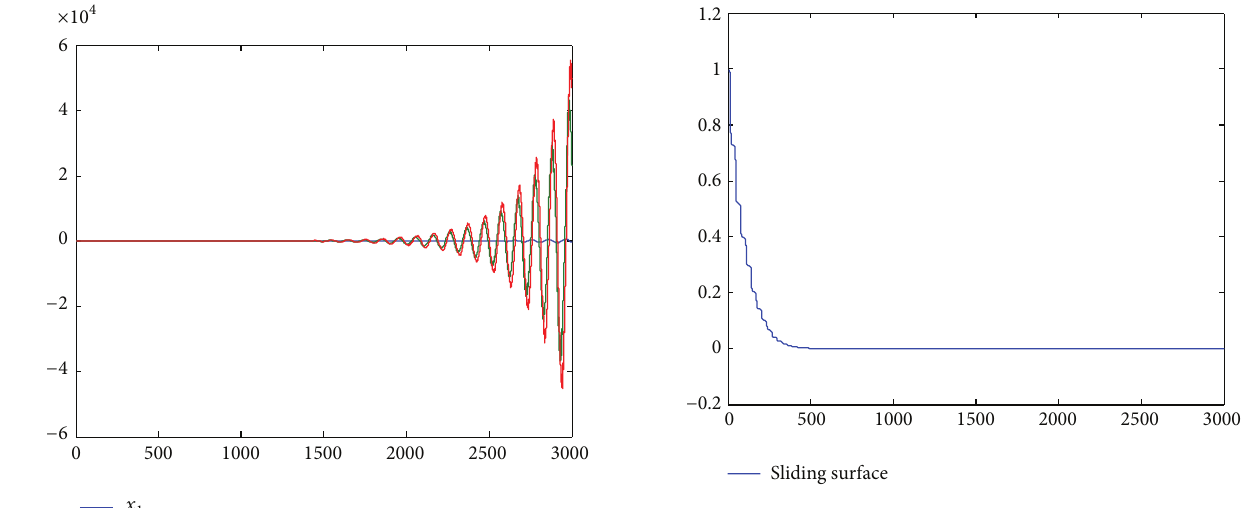
Figure 3: Sliding surface with system uncertainties and control.